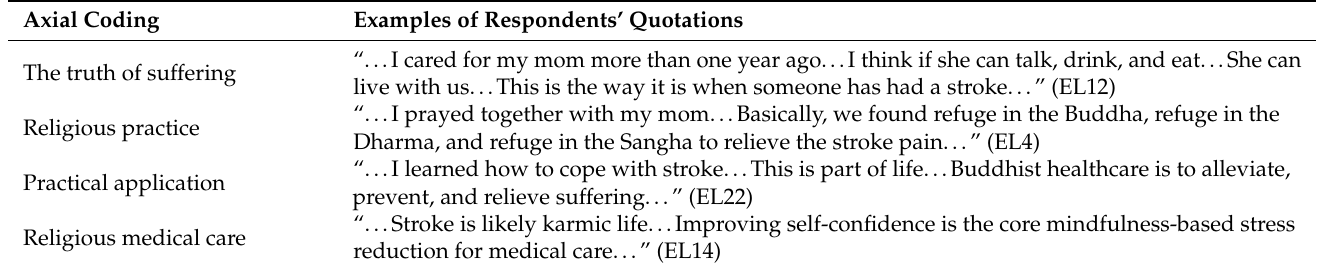
Table A2. An example of axial